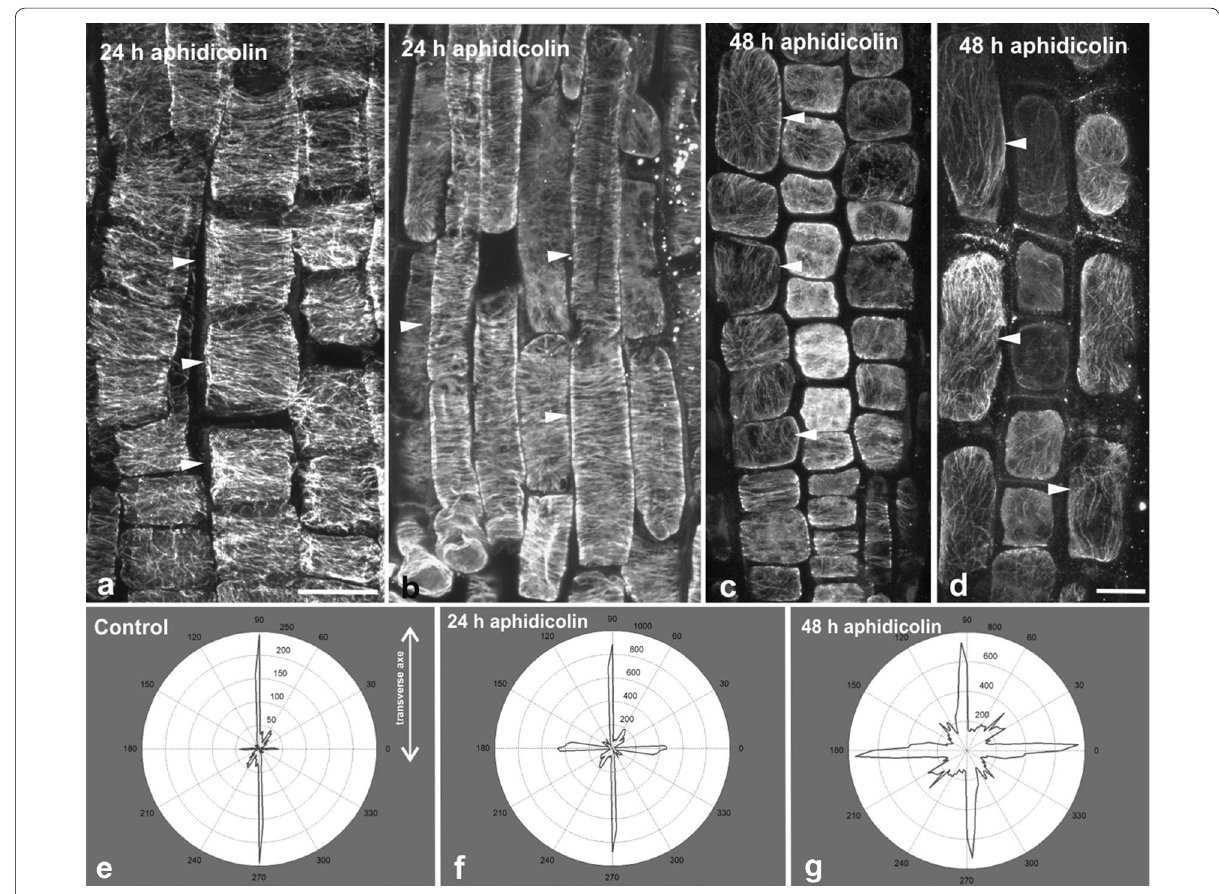
Fig. 3 Cortical microtubule orientation at the external face of epidermal cells in the transition (i.e. under the shootward part of the lateral root cap; a , c ) and fast elongation ( b , d ) zones of aphidicolin‑treated roots. All images are maximum projections of serial CLSM sections. After 24 h of treatment, microtubules are transverse (arrowheads) in the transition ( a ) and fast elongation ( b ) zone, while after 48 h of treatment they appear randomly oriented in both zones ( c , d ). Representative decipher‑graphs of microtubule alignment in transition and elongation zone cells of control roots ( e ), and after 24 h ( f ) and 48 h ( g ) of aphidicolin treatment. Decipher‑graphs show that microtubules are transversely oriented (doubled‑headed arrow) in the control and after 24 h of aphidicolin treatment ( e and f , respectively), while the frequency of longitudinal and/or randomly oriented microtubules increased after 48 h of treatment ( g ). Scale bar 10